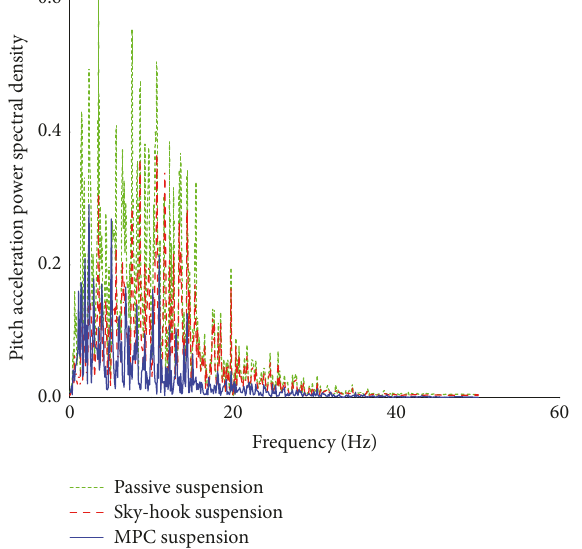
Figure 11: Pitch acceleration power spectral density.